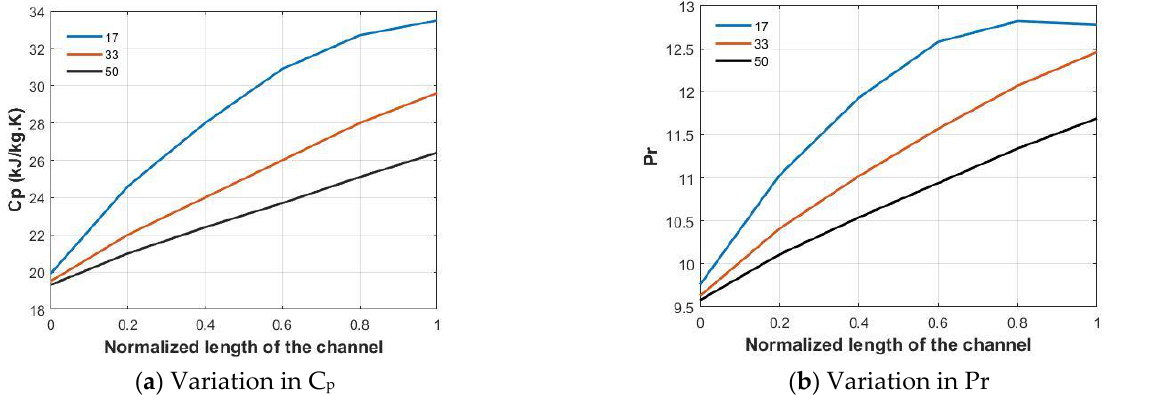
Figure 10. Variation in ( a ) specific heat capacity and ( b ) Prandtl number for different sCO 2 mass flow rate with t f = 0.5, S f = 0.5 and H f = 2 mm .